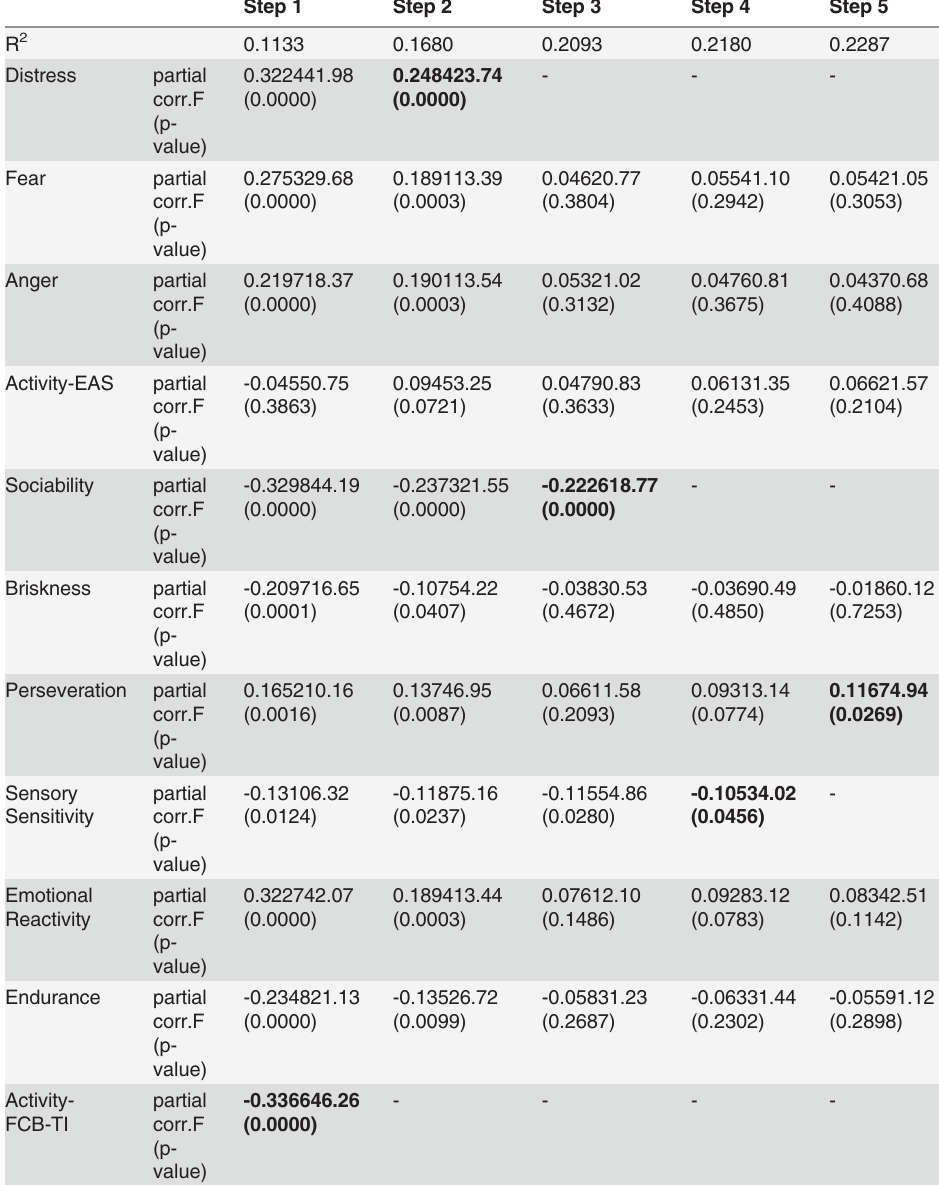
Table 3. Results of Forward Entry Selection Regression Analysis in a group of females, involving Total-AQ variable as a predicted parameter and EAS-TS and FCB-TI scales as